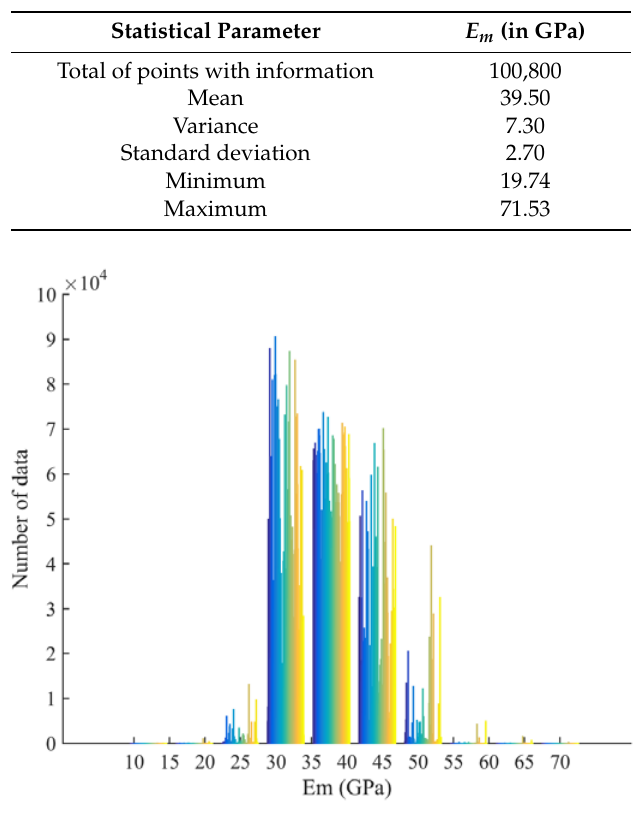
Figure 6. Histograms of the E m values (in GPa) obtained for all of the 100 realisations (each colour represents one realisation).